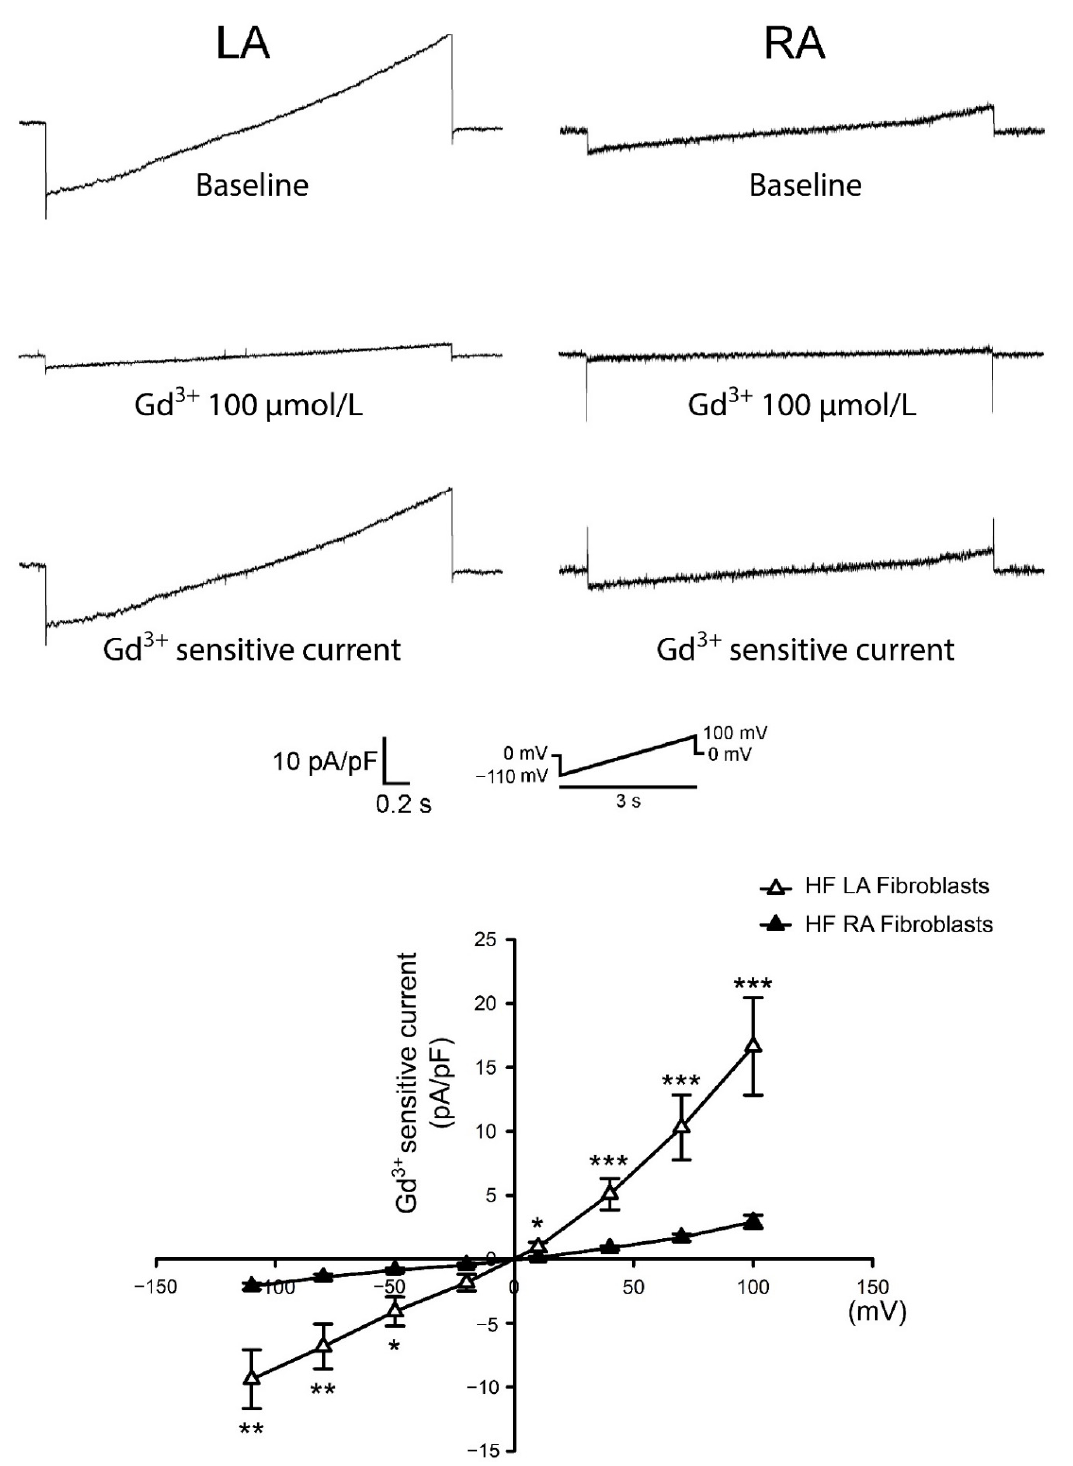
Figure 5. Membrane gadolinium (Gd 3+ )-sensitive currents in isolated passage 0 (P0) left atrium (LA) and right atrium (RA) fibroblasts from heart failure (HF) rats. Left panels reveal tracings of the Gd 3+ (100 μ mol/L)-sensitive non-selective cation current from HF LA fibroblasts (n = 10 from six rats), HF RA fibroblasts (n = 10 from five rats). Right panels reveal the current/voltage (I/V) relationship of the Gd 3+ -sensitive non-selective cation current. * p < 0.05, ** p < 0.01, *** p < 0.005. The insets in the current traces show the various clamp protocols.